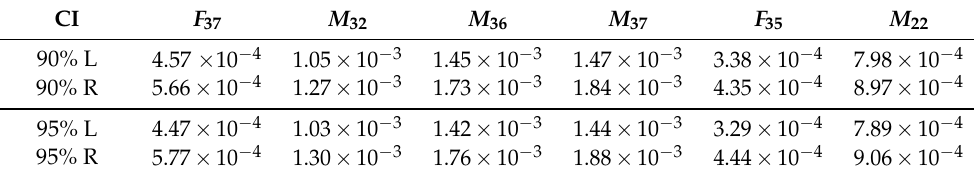
Table 2. The 90% and 95% CI for the forecast of the mortality rates (2020–2027; L: left, R: right).